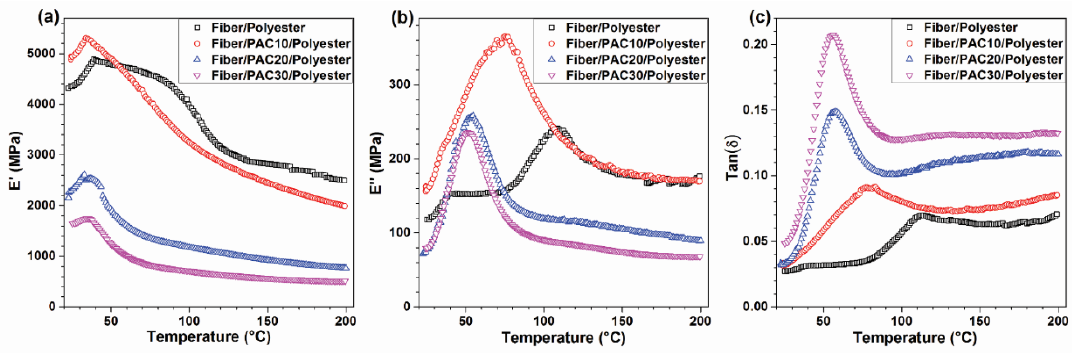
Figure 4. DMA results of the four composites, including storage modulus ( a ); loss modulus ( b ); and damping parameter ( c ).